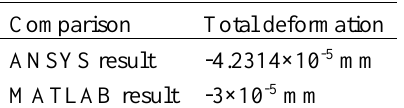
Comparison of results for the simply supported beam with